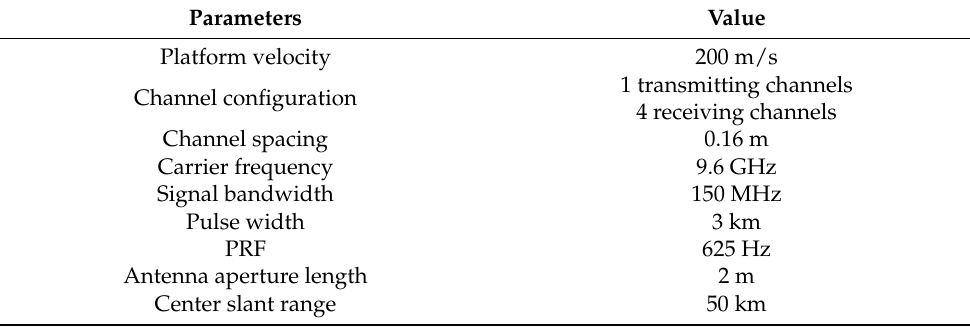
Table 3. Simulation